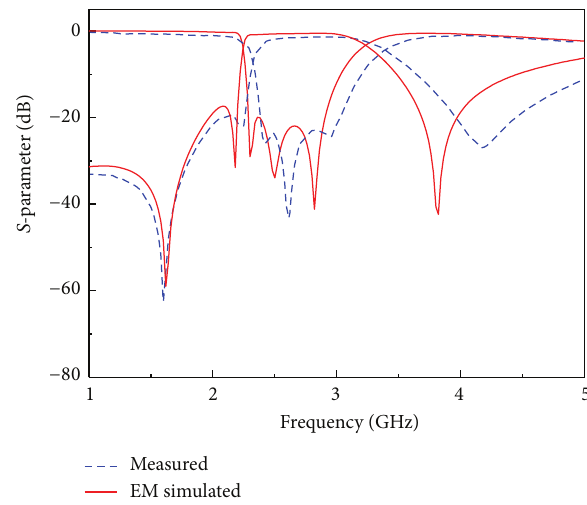
Figure 7: Comparison between EM simulated and measured results of the proposed filter.